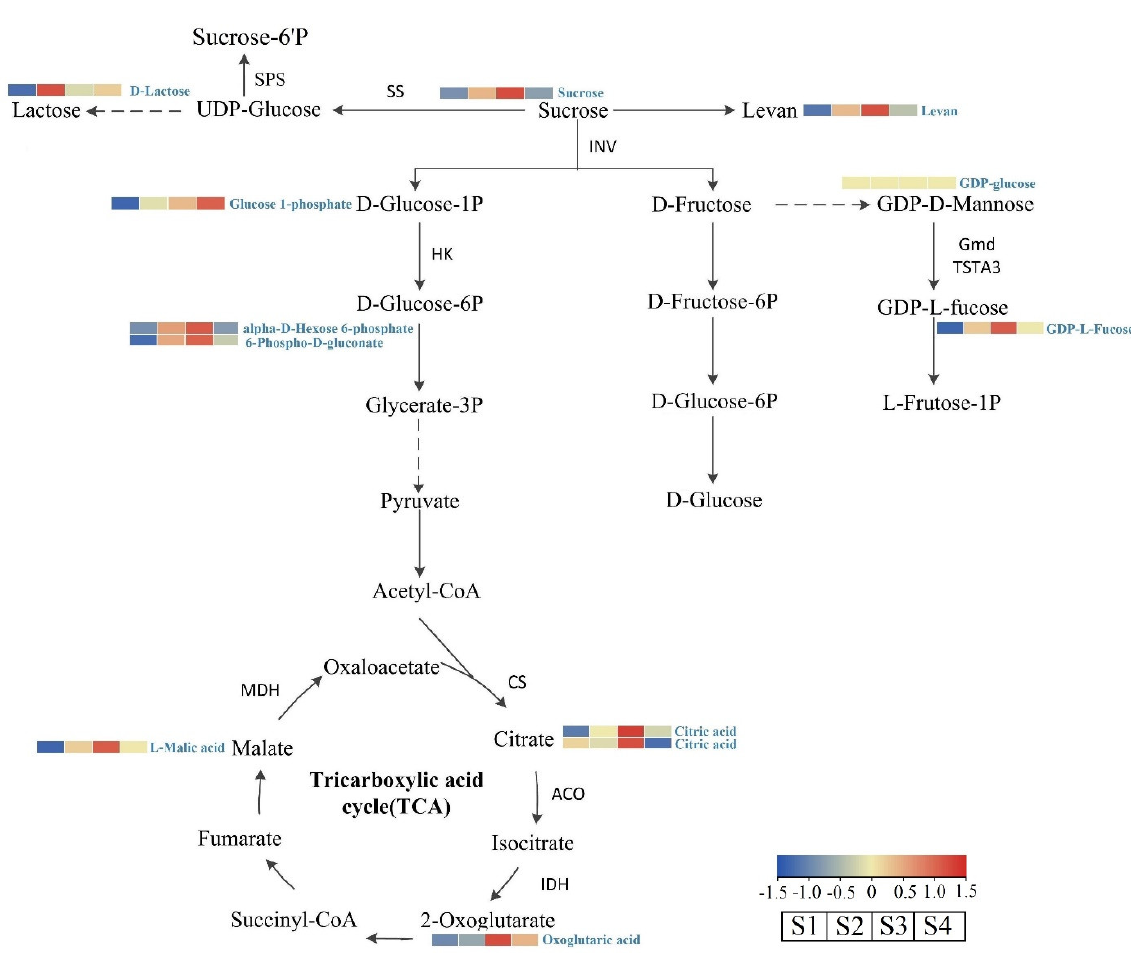
Figure 8. Biosynthesis pathway of sugar and TCA cycles in four developmental stages. The colored squares represent the expression levels of different metabolites in S1–S4 period shown by heatmap. SS: Sucrose synthase; SPS: sucrose phosphate synthase; INV: invertase; HK: hexokinase; Gmd: GDP mannose 4,6-dehydratase; TSTA3: GDP-L-fucose synthase; CS: citrate synthase; ACO: aconitate hydratase; IDH: isocitrate dehydrogenase; MDH: malate dehydrogenase.